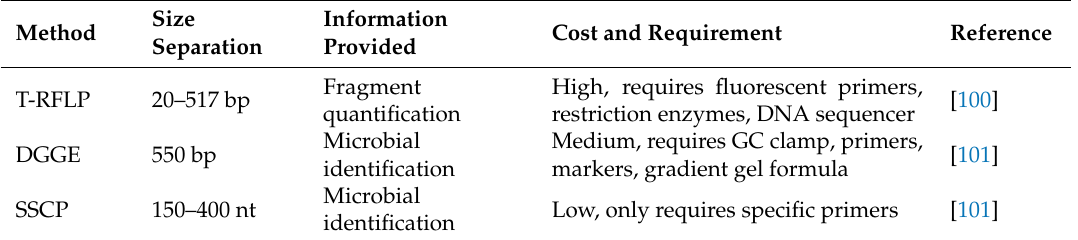
Table 7. Comparison of genotyping fingerprinting